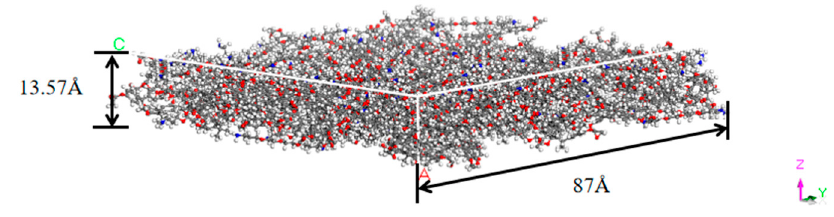
Figure 4. The model of the adhesive layer.